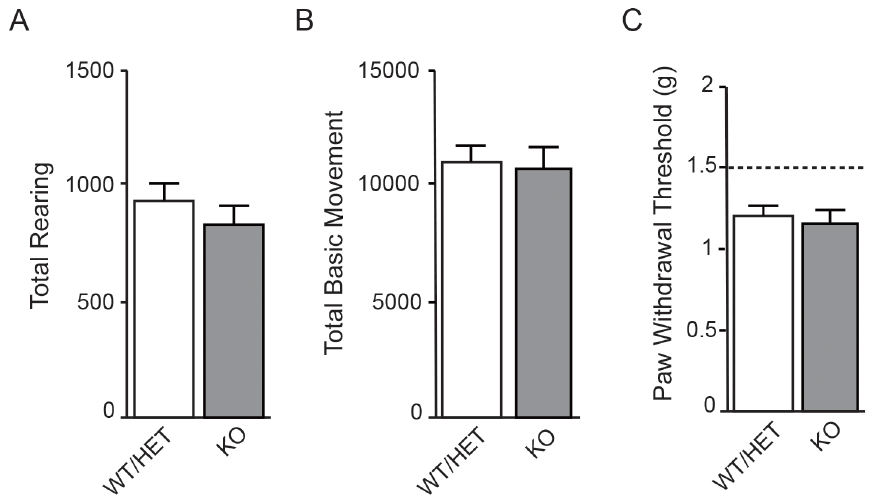
Figure 3. Baseline movement and tactile sensitivity of Nav1.7 KOs are not different from WT/HET. Overall locomotion was evaluated in Nav1.7 WT/HET and KO animals by scoring both total rearing behavior and basic movement using beam breaks in an automated open-field box. A. There was no statistically significant difference in rearing behavior between WT/HET (11187 6 492, n=20) and KO (11036 6 781, n=17) littermates (pairwise t-test, p=0.2438). B. There was no statistically significant difference in basic movement between WT/HET (935 6 85, n=20) and KO (835 6 75, n=17) littermates (mean 6 S.E.M.; pairwise t-test, p=0.528). C. Tactile sensitivity, as assayed by measuring threshold of paw withdrawal to von Frey fibers of increasing force, was not significantly different between WT/HET (1.225 g 6 0.05 g, n=11) and KO littermates (1.18 g 6 0.08 g, n=7) (mean 6 S.E.M.; Wilcoxon Two-Sample Exact Test, p=0.6434). Dashed line represents the level at which the animal’s paw was physically lifted by the von Frey monofilament and is included to show that the measured responses are due to true behavioral tactile